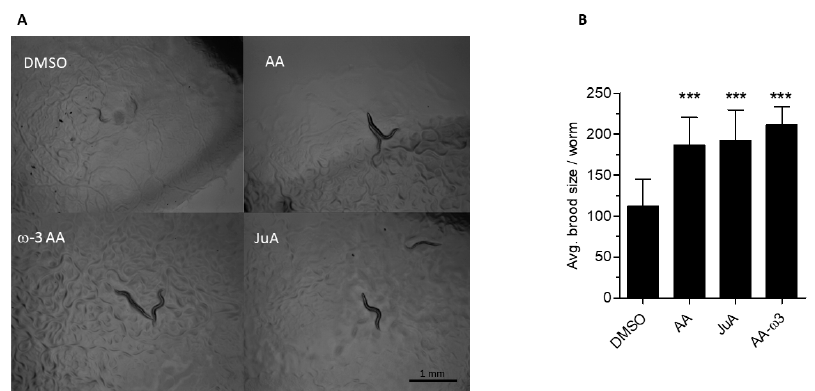
Figure 2. Recovery of growth defects with addition of FAs. ( A ) Recovery of growth delay after 36 h of hatching at 23 ◦ C of fat-3 ( wa22) mutant with the supplementation of C20:4 FAs (Scale bar = 100 mm). ( B ) Brood size of fat-3 ( wa22 ) C. elegans after addition of di ff erent C20:4 FAs. Brood size experiments were carried out with n = 5 animals per condition in at least three independent trials (*** p < 0.0001). Data show mean values ± SD.